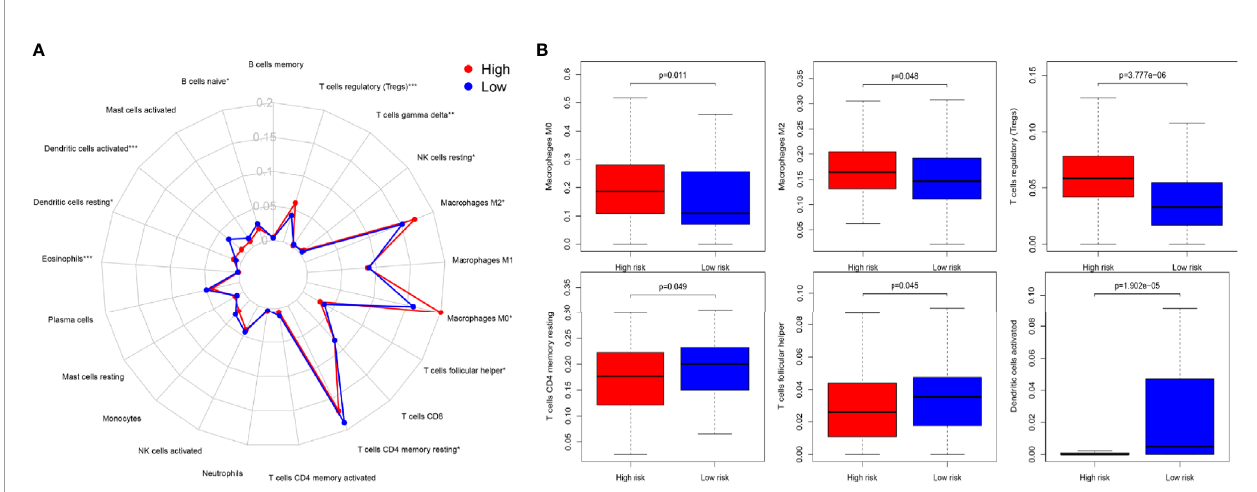
FIGURE 4 | (A) Summary of the 22 immune cell types abundance estimated by “ CIBERSORT ” within different risk groups. (B) The differences of 22 immune cell types abundance within different risk groups. Macrophage M0 ( p = 0.011), macrophage M2 ( p = 0.048), and Treg cells ( p < 0.001) were signi fi cantly highly expressed in the HSG. Activated memory CD4+ T cells ( p = 0.049), T follicular helper ( p = 0.045), and activated dendritic cells (aDC) ( p < 0.001) were signi fi cantly higher in the